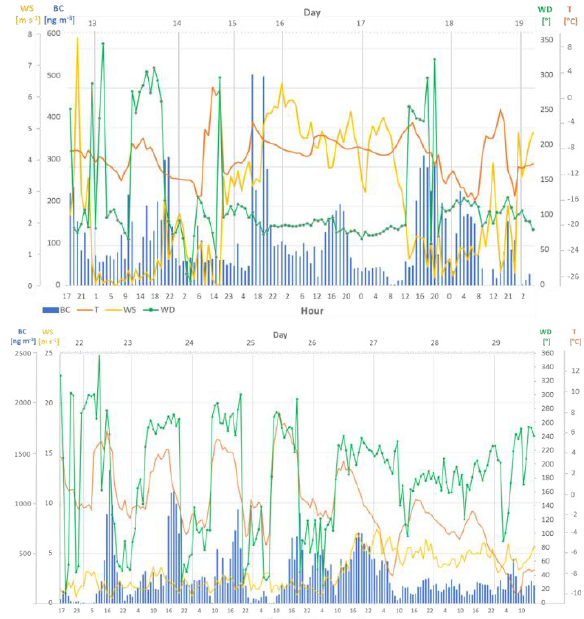
Figure 7. BC concentration in snow samples obtained in OAG and